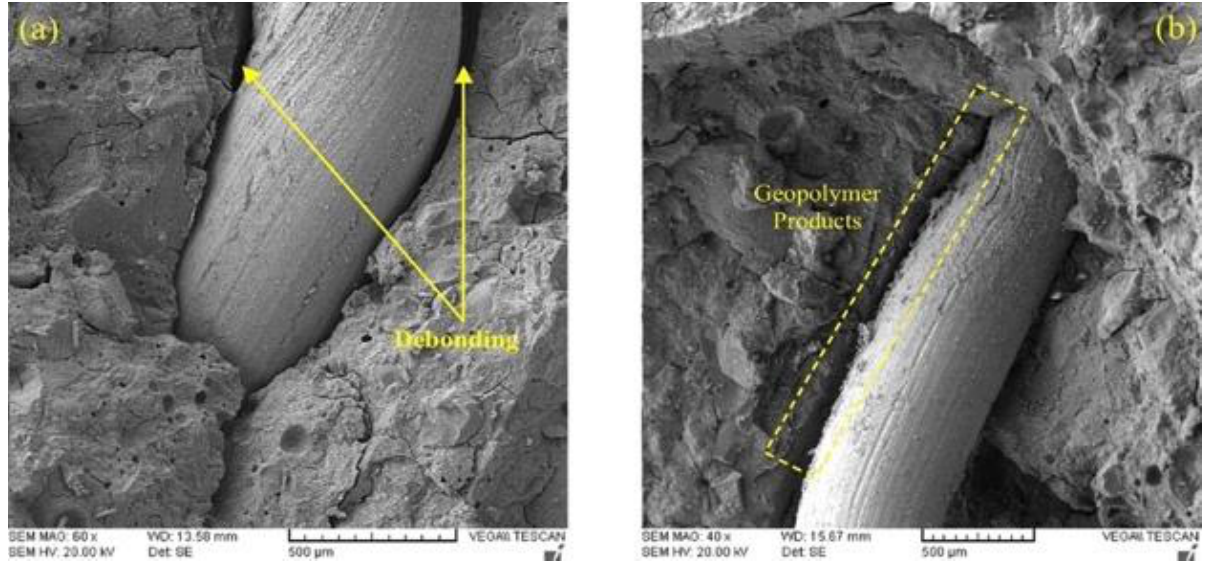
Figure 9. SEM images of uncoated steel fiber matrix transition zone. Debonding at the interface ( a ) and geopolymeric products on the surface of steel fiber ( b ) [52].